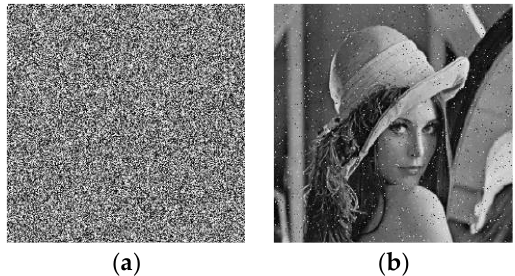
Figure 12. Salt and pepper noise intensity of 3%: ( a ) encrypted image and ( b ) decrypted image.